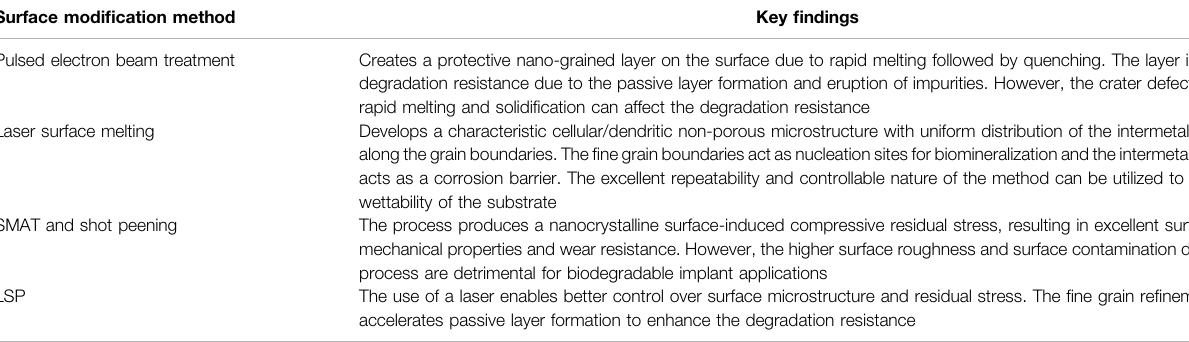
TABLE 3 | Key fi ndings from surface metallurgical modi fi cation methods. Surface modi fi cation